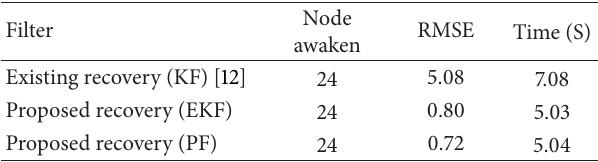
Table 1: Performance comparison: node failure—Case I.